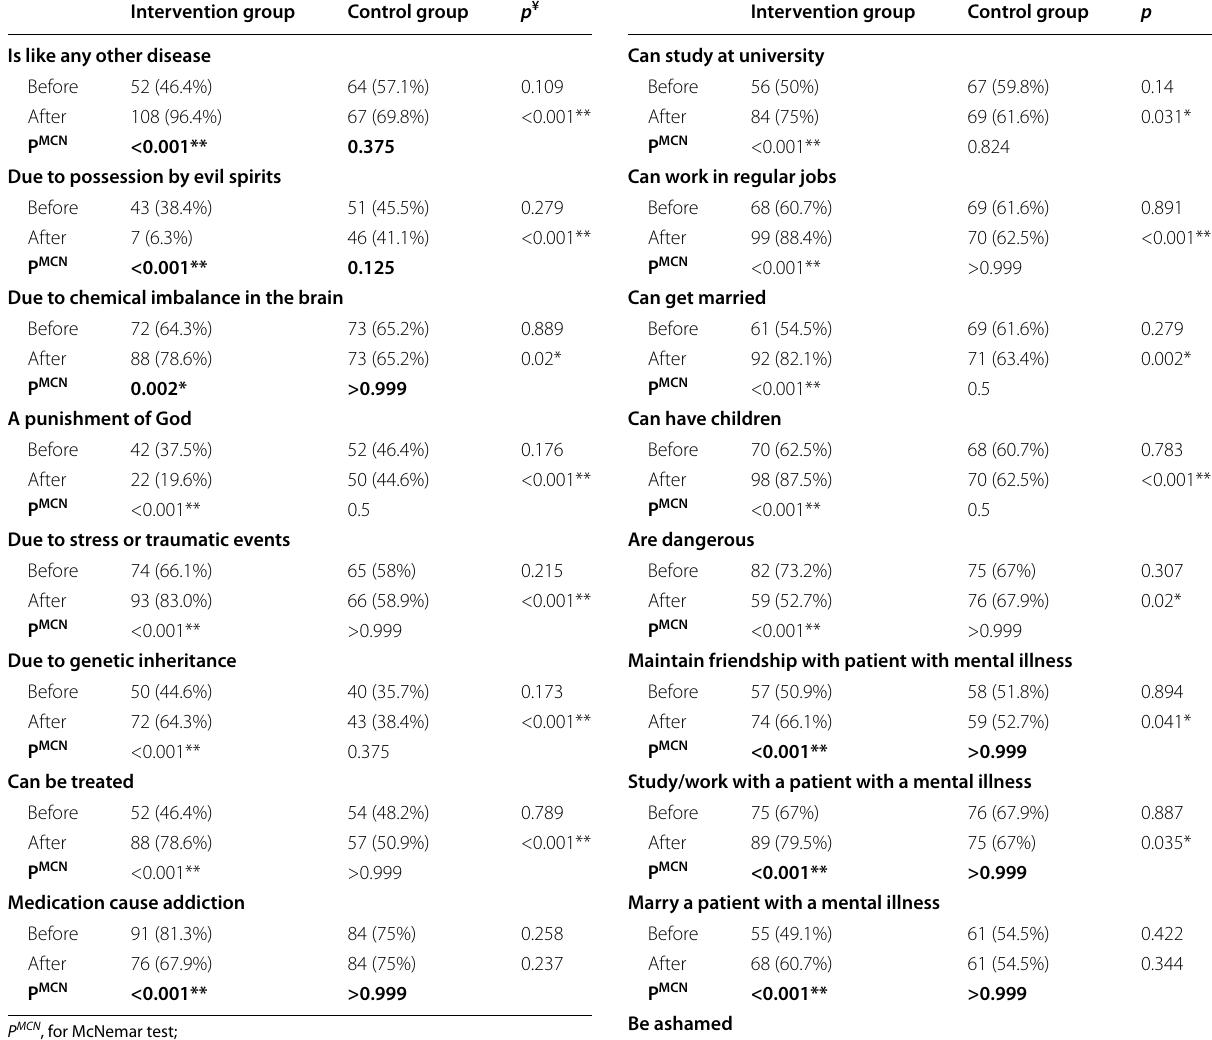
Table 3 Differences in beliefs towards mental illness between intervention and control groups (yes)